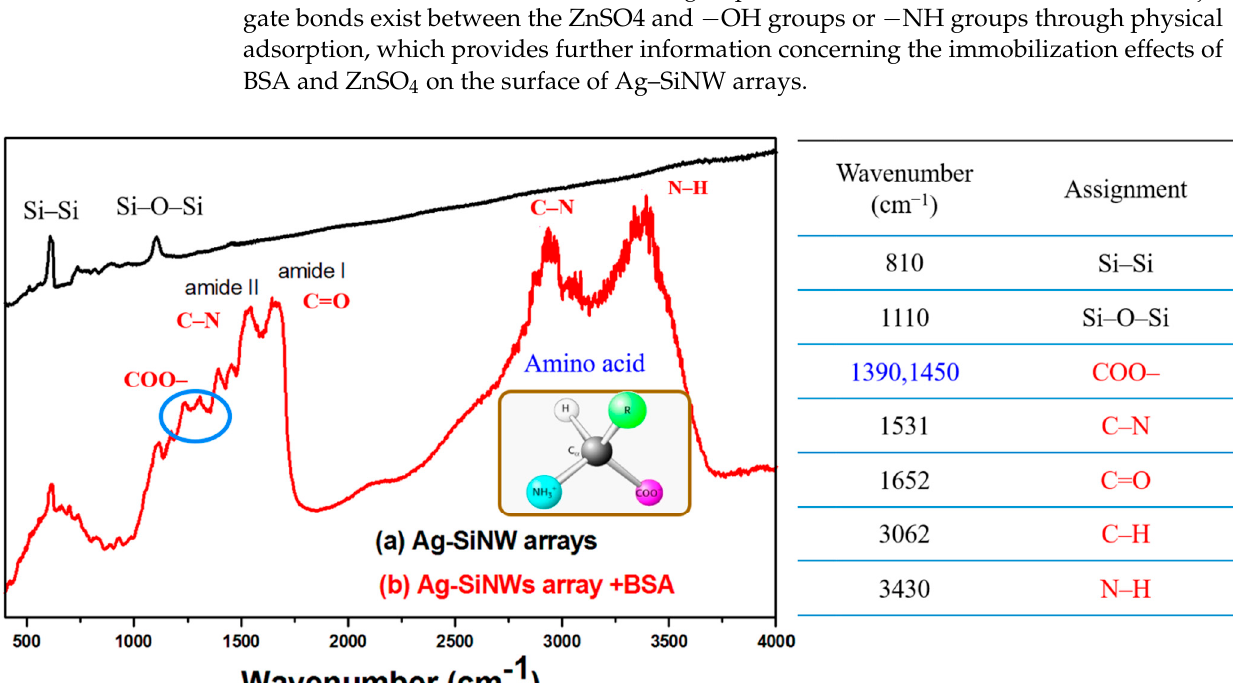
Figure 9. Comparison of FTIR spectra of the Ag–SiNW arrays ( a ) immobilized with BSA and ZnSO 4 (black line) and ( b ) immobilized with BSA (red line). 3.3. SERS Biodetection and Detection of Heavy Metal Ions It has been known that SERS signals, while interacting with targeted molecules, ena- ble the detection and identification of molecules, without the need of exogenous labels, due to the inherent vibrational signatures and the specific spectral of species [4–6]. The SERS signals enhanced by silver nanoparticles have also been investigated in the literature [7,13,14]. The SERS spectra, that is, the Raman analysis of BSA protein on Ag–SiNW arrays and BSA protein conjugation, are shown in Figure 10. When BSA proteins were adsorbed